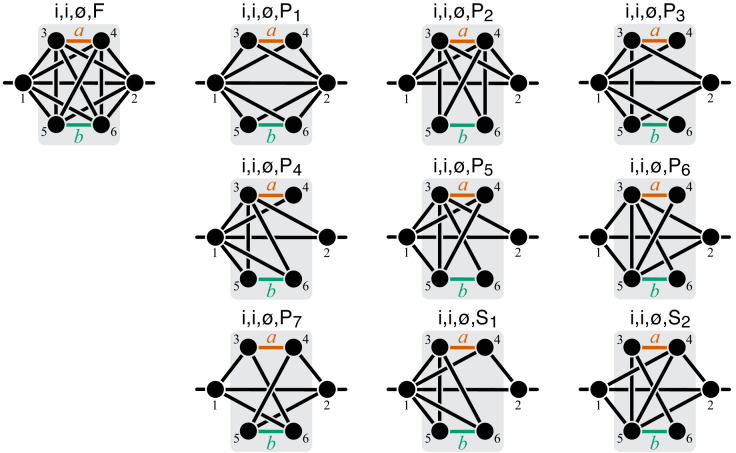
Graphical representation of strictly serial and strictly parallel generating topologies in class Mi,i,∅.Fully connected topology i,i,∅,F is shown for reference (same as in Figure 8).